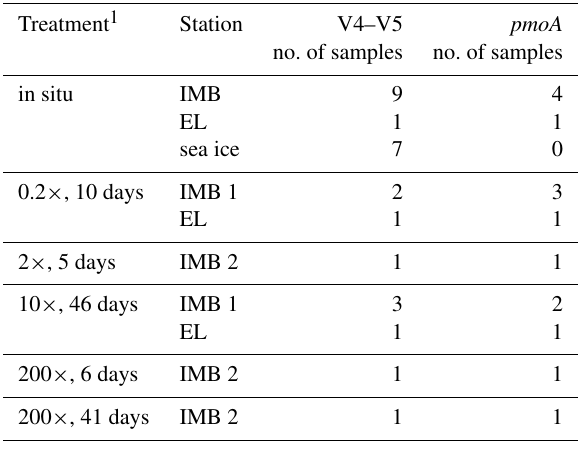
Table 2. Samples sequenced for V4-V5 and pmoA